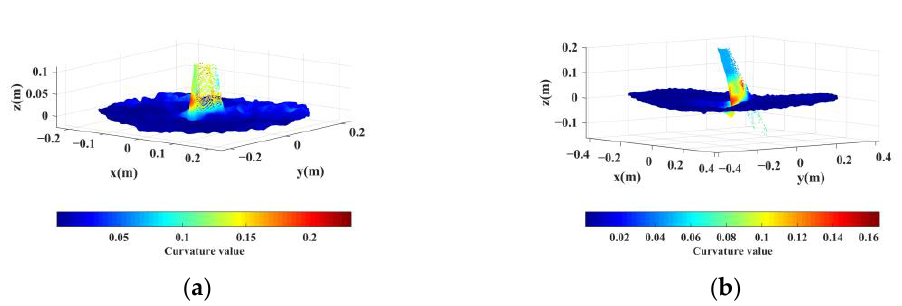
Figure 9. Curvature distribution of clusters containing anchor points. ( a ) Anchor rod in normal condition. ( b ) Anchor rod with significantly mixed pixels.